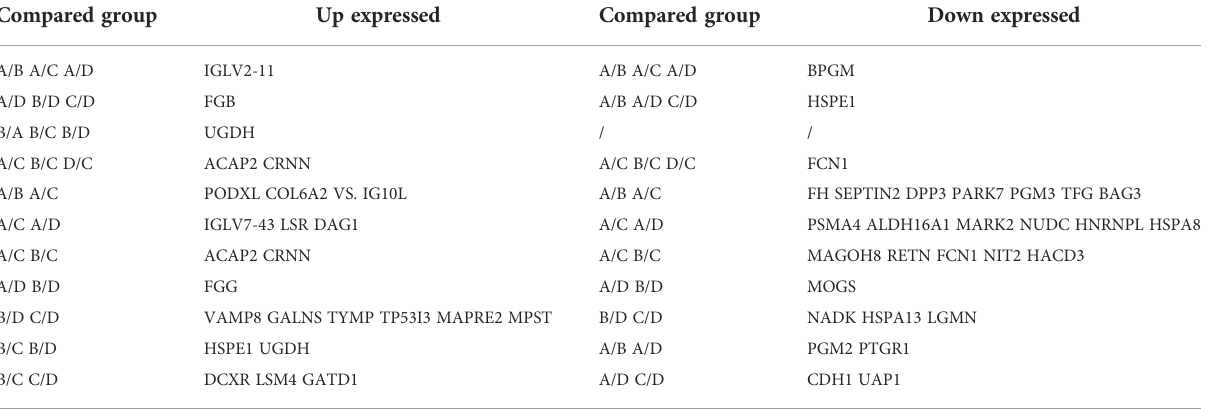
TABLE 3 Common up and down DEPs in saliva between four IgG4-RD subgroups. Compared